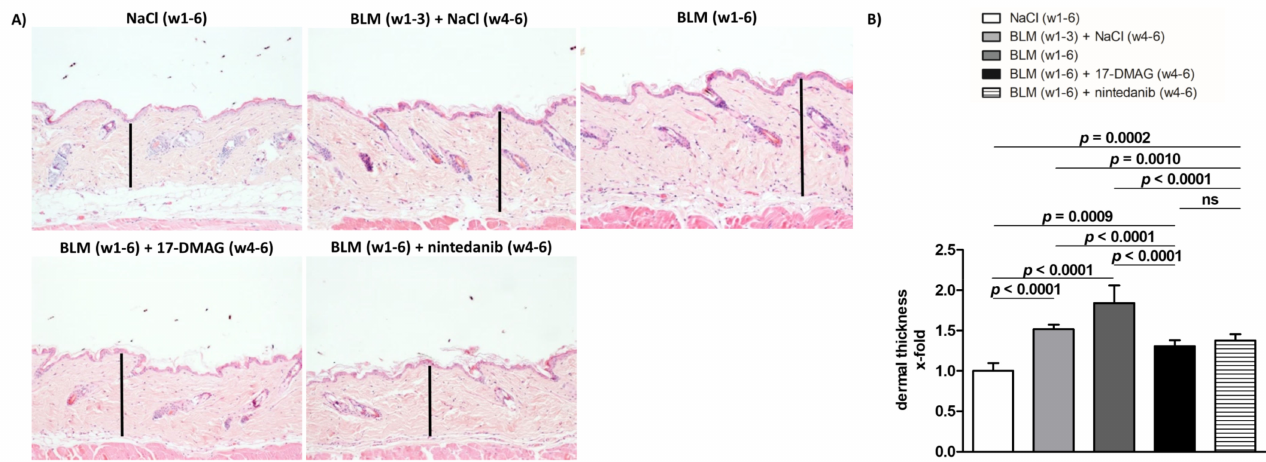
Figure 2. Treatment with 17-DMAG prevents further progression and may induce regression of dermal thickening induced by bleomycin. ( A ) Representative images of hematoxylin and eosin-stained skin sections are shown. Original magnification × 100. Vertical bars represent the dermal thickness. ( B ) Treatment with 17-DMAG prevents further progression and may induce regression of dermal thickening induced by bleomycin. The extent of the protective effects of 17-DMAG is comparable to the effect of the treatment with nintedanib. Columns represent the mean, and whiskers represent the standard error of the mean. w, week; NaCl, sodium chloride; BLM, bleomycin; 17-DMAG, 17-dimethylaminoethylamino-17- demethoxygeldanamycin (inhibitor of heat shock protein 90); ns, not significant ( p ≥ 0.05); n = 8 mice in each